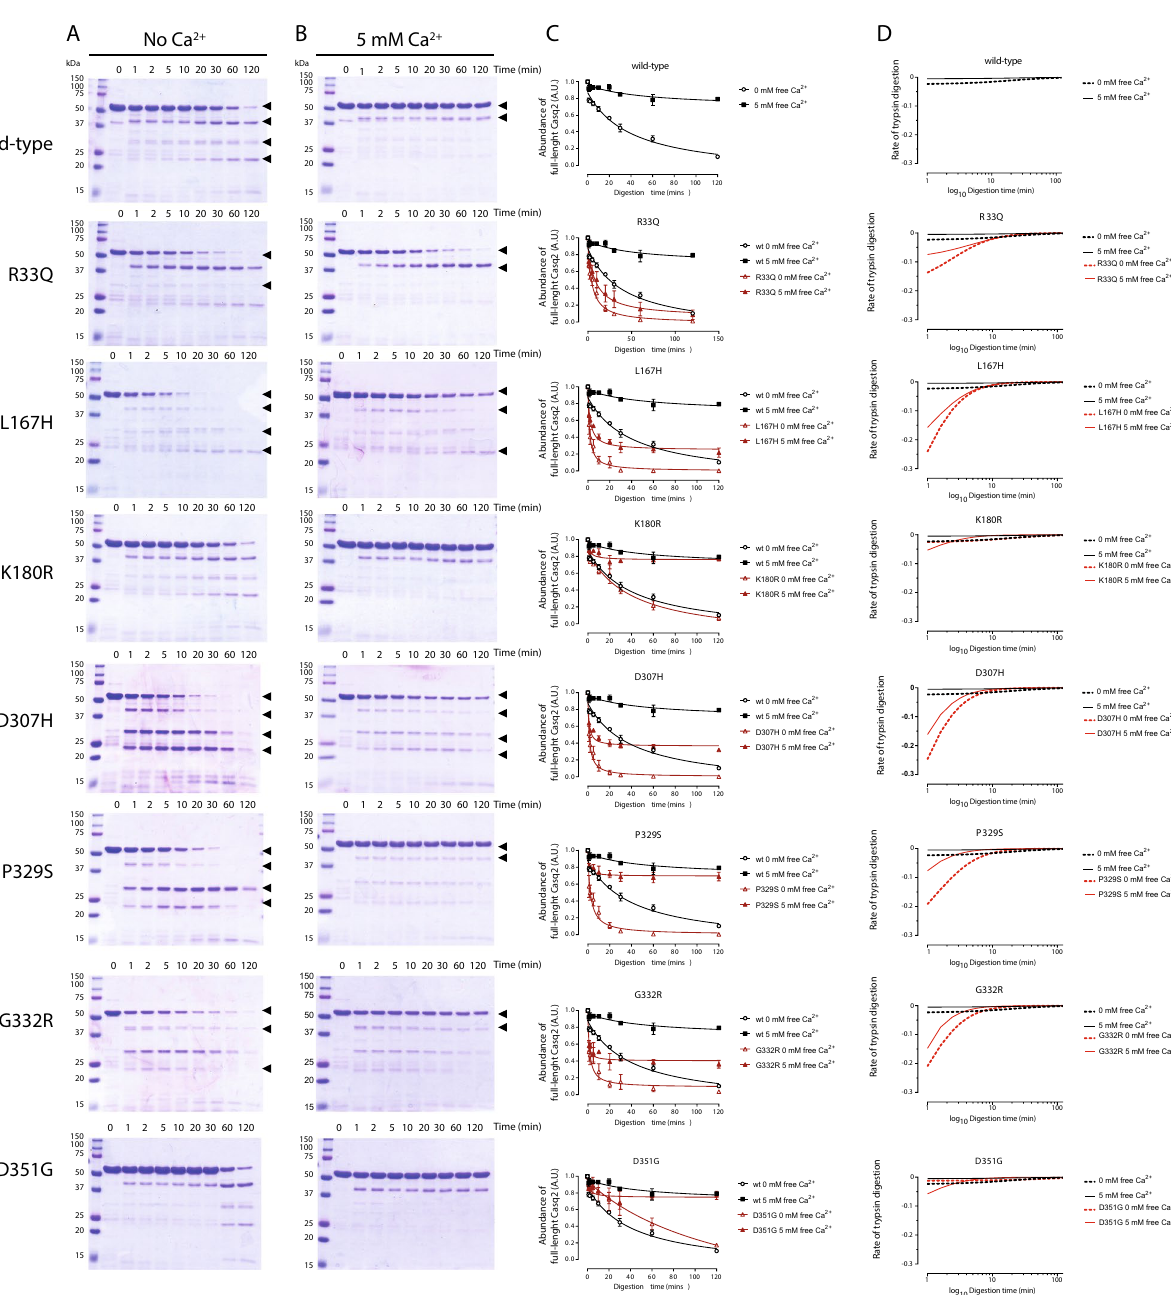
mutations in these regions of the protein are expected to impact protein structure and function 60,61 . Not sur- prisingly, Casq2 mutations associated with CPVT are dispersed throughout different protein regions, but all are highly conserved throughout metazoans some (R33Q, K180R, D307H, P329S and G332R) even including pre- duplication Casq. Because of a specific disease phenotype of Casq2 mutants, one a priori prediction is that the mutations associated with CPVT would be in sites conserved in Casq2 but divergent in Casq1 and preduplicates, providing gain-of function amino acid changes in Casq2 which were then disrupted by the disease phenotype- associated mutations. However, this was not what we observed. Instead we found strong conservation at these positions between the paralogues or indeed across all calsequestrin homologues. This suggests that the residues at these positions are critical for calsequestrin function. Specificity of cardiac disease seen with Casq2 mutants